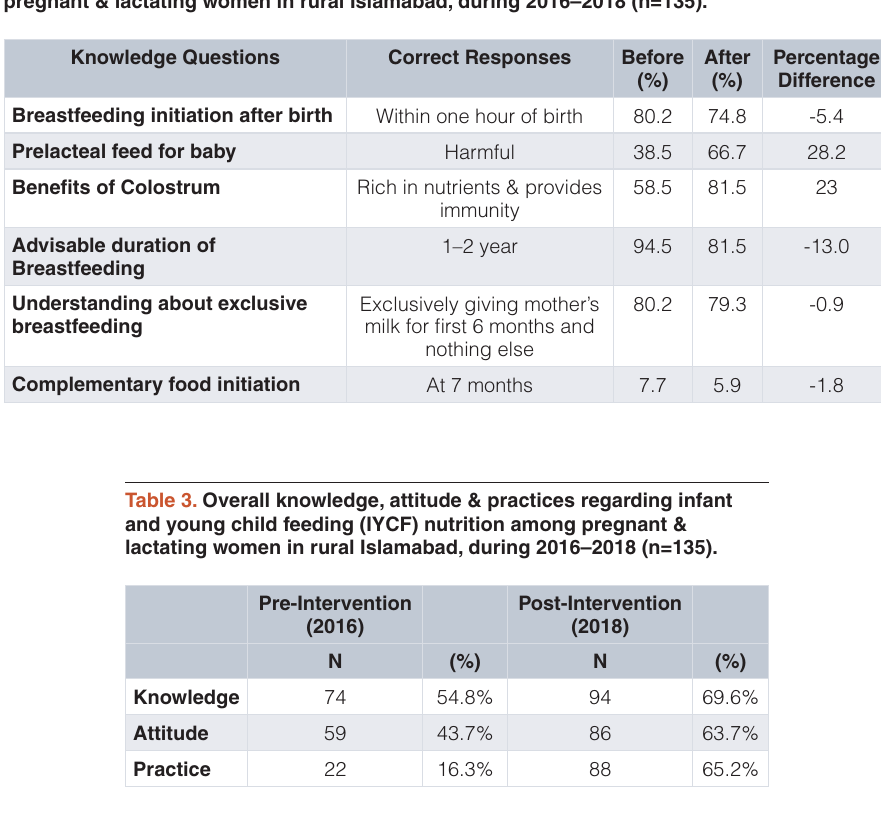
Table 2. Knowledge regarding infant and young child feeding (IYCF) nutrition among pregnant & lactating women in rural Islamabad, during 2016–2018 (n=135).